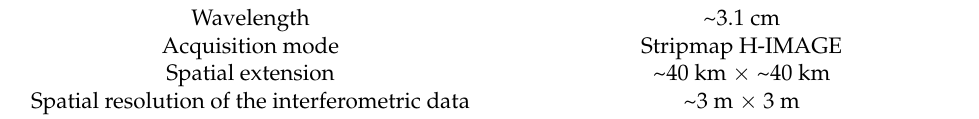
Table 2. Main parameters of the dataset.